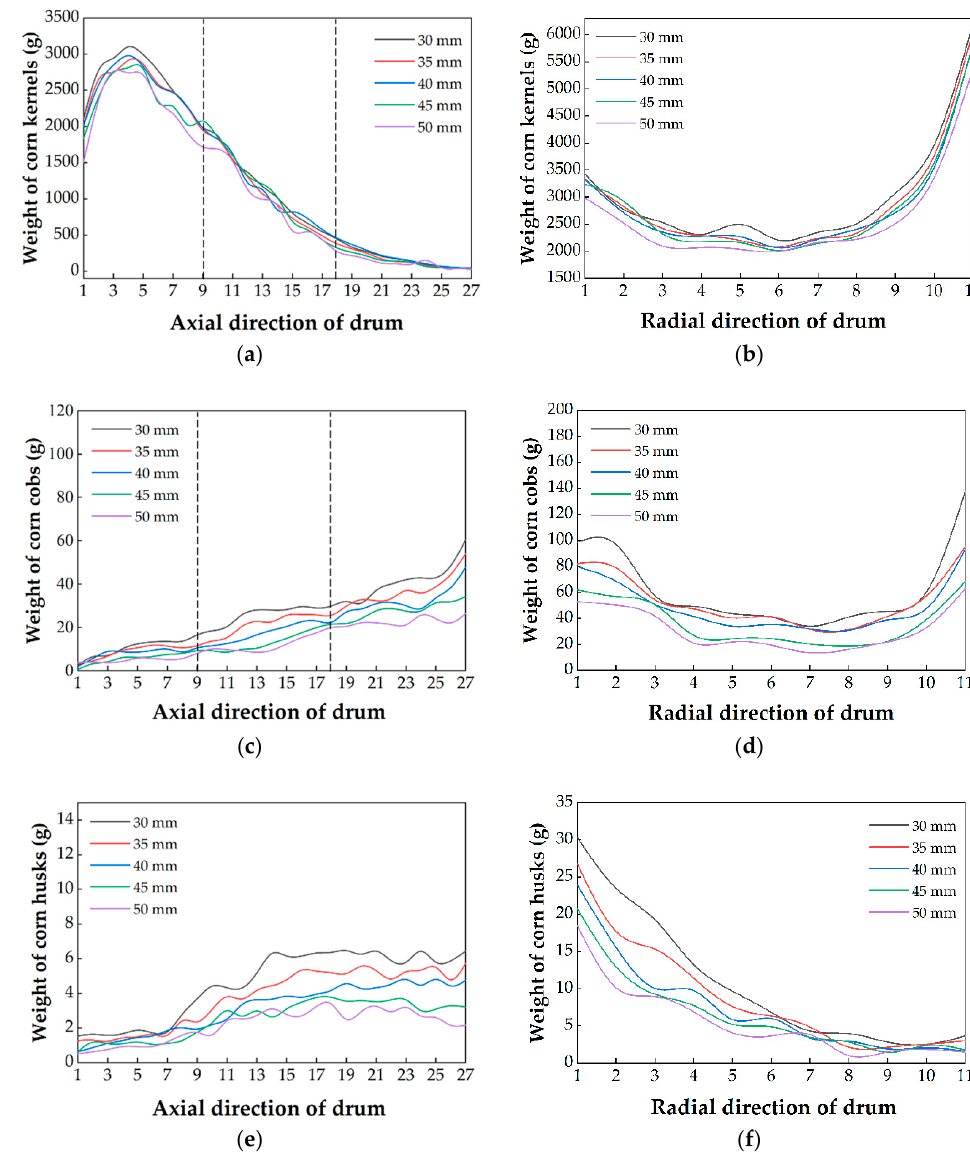
Figure 11. Weight distribution of components for different concave clearances. Weight distribution curves in the axial and radial directions of ( a , b ) corn kernels, ( c , d ) corn cobs, and ( e , f ) corn husks.